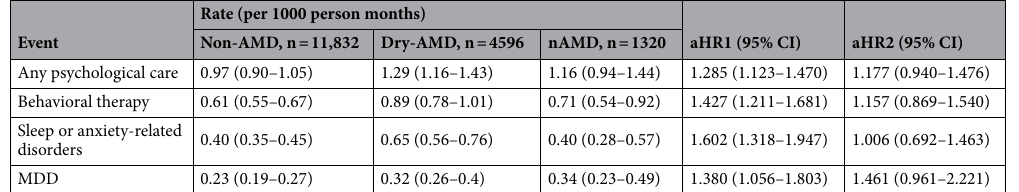
Table 3. Study events in different types and treatments of age-related macular degeneration and control groups. AMD age-related macular degeneration, nAMD neovascular age-related macular degeneration, n number, aHR adjusted hazard ratio adjusted for age, sex, education, marital status, and comorbidities, CI confidential interval, MDD major depression disorder, aHR1 the hazard ratio of dry-AMD compared with non-AMD individuals, aHR2 the hazard ratio of nAMD compared with non-AMD individuals. *Significant difference. # Crude incidence rate per 10,000 person months.